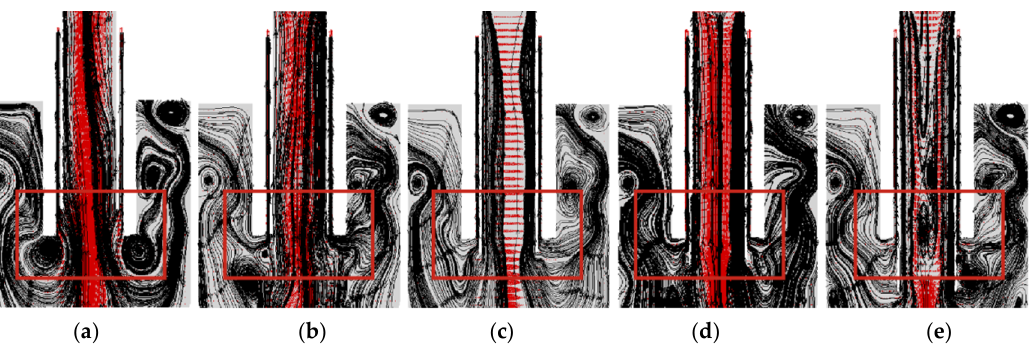
Figure 14. Slurry movement trajectory of hydrocyclone under different length of internal vortex finder. ( a ) 0.86L ( b ) 1.00L ( c ) 1.06L ( d ) 1.13L ( e ) 1.26L.